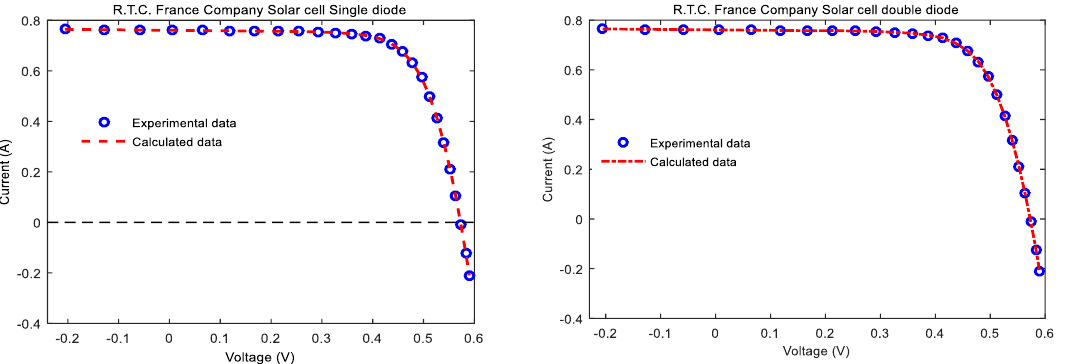
Figure 7. Experimental current-voltage data compared with estimated data of the ono-crystalline silicon solar cell single diode, RTC France Company.